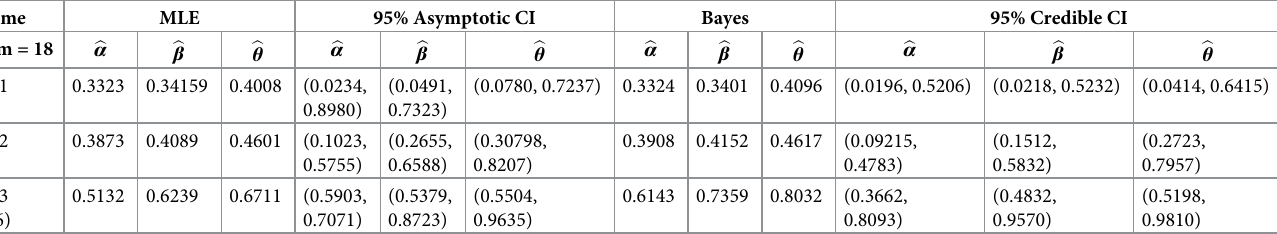
Table 2. MLE and Bayes point and interval estimate for real data